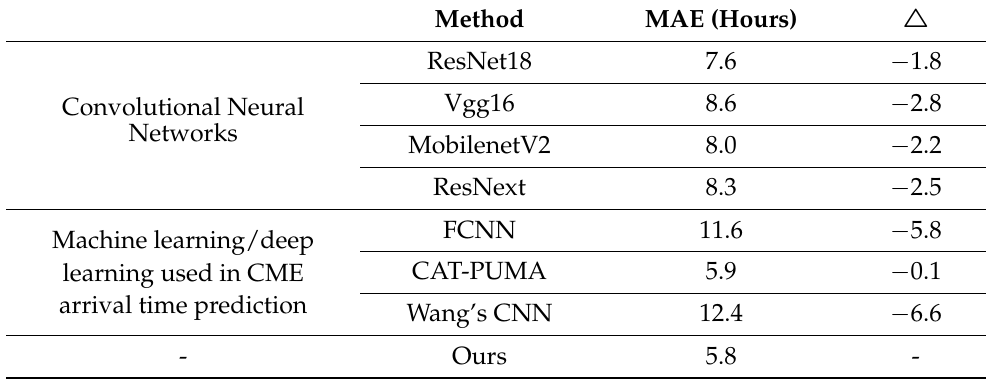
Table 4. Comparison of the arrival time prediction for geoeffective CMEs with other methods.